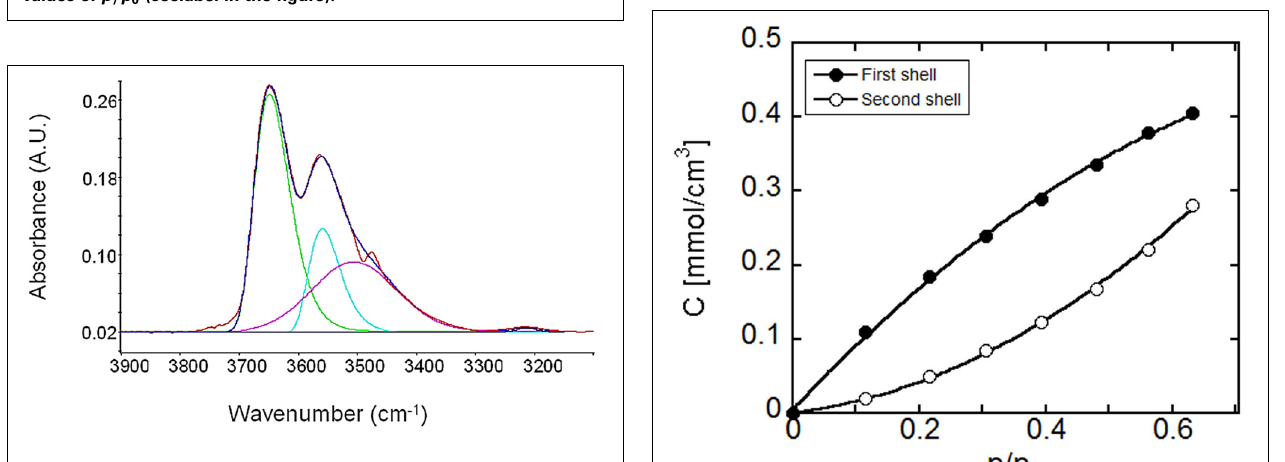
FIGURE 10 | LSCF analysis of the ν OH region for PEI equilibrated with water vapor at p / p 0 = 0 . 7.